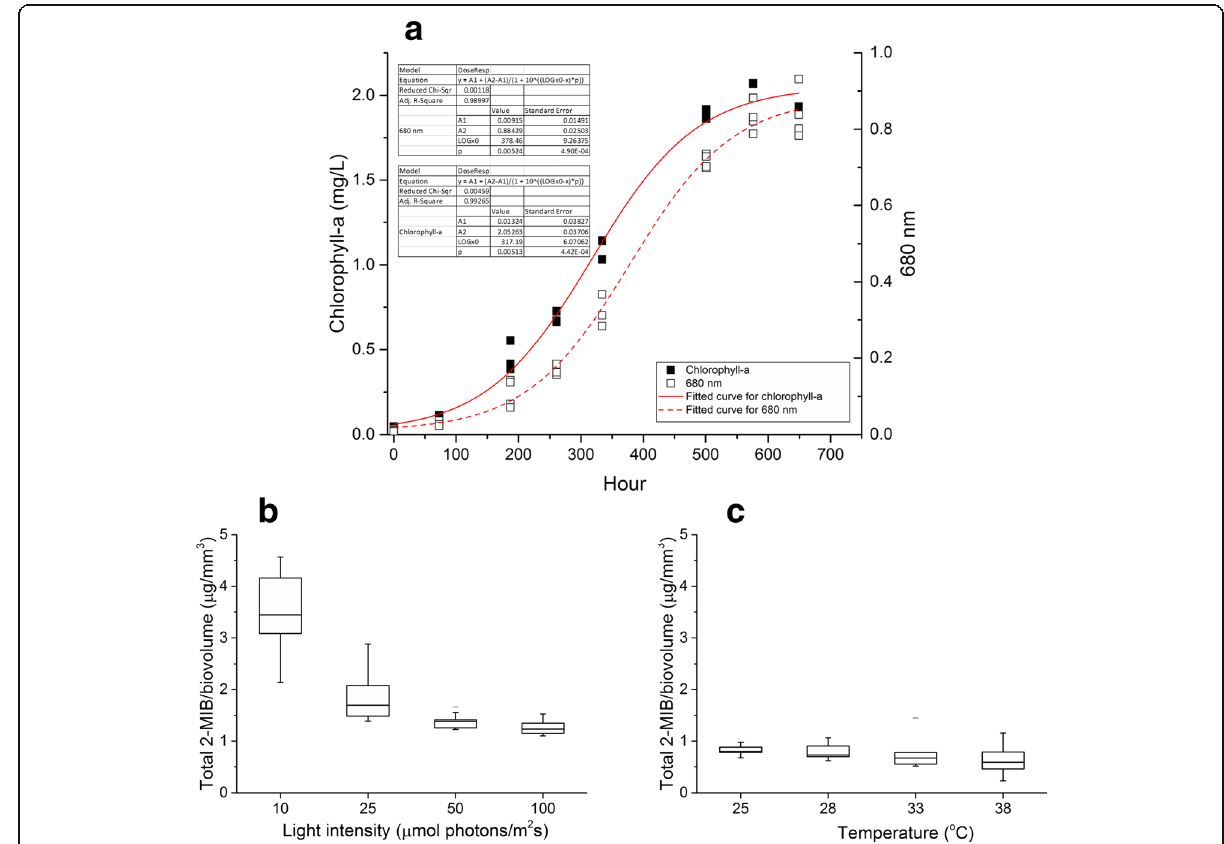
Fig. 3 a Growth curves of Planktothricoides sp. SR001 fitted with dose-response model. Estimated growth rates are 0.00524 h -1 and 0.00513 h -1 based on optical density and chl-a, respectively; b Changes of 2-MIB content for Planktothricoides sp. SR001 under different light intensity and, c temperature conditions. 2-MIB contents are normalized to cell biovolume